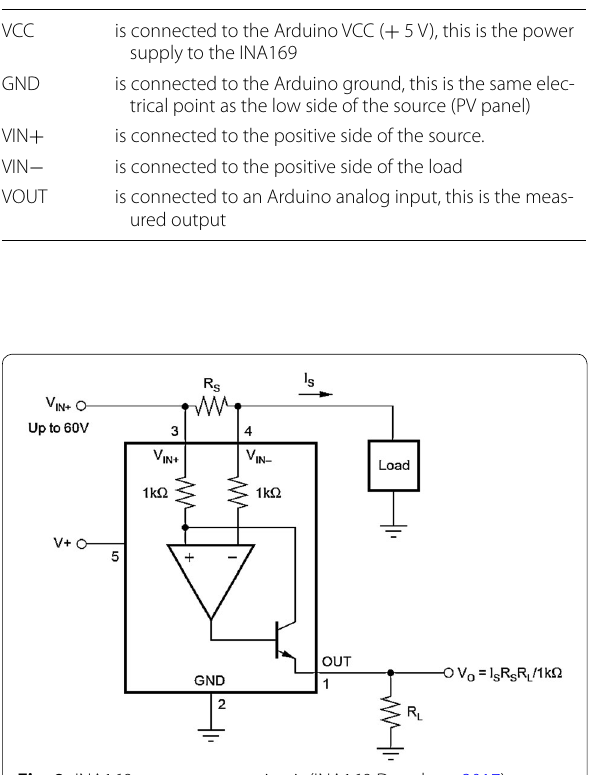
Fig. 9 INA169 current sensor circuit (INA169 Datasheet